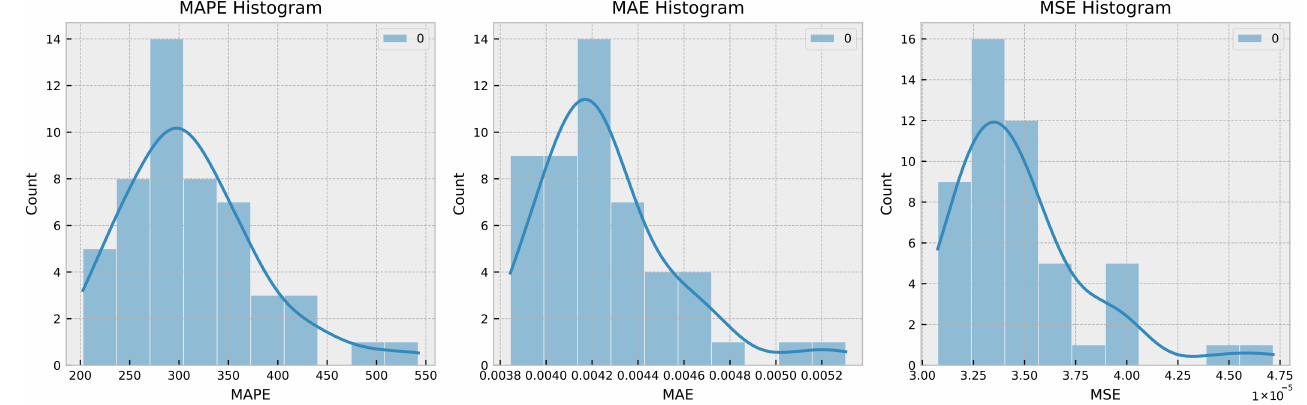
Figure 7. Histogram of MSE, MAE, and MAPE for 50 runs with Gaussian noise. From the histogram and boxplot, it is clear that the model’s variance remains within acceptable limits. This indicates that the model is resilient and capable of performing well across a broad range of training data and parameter settings. In addition, the boxplot reveals that the median performance measure values are consistent across all 50 training runs with random Gaussian noise, further supporting the robustness of the model.